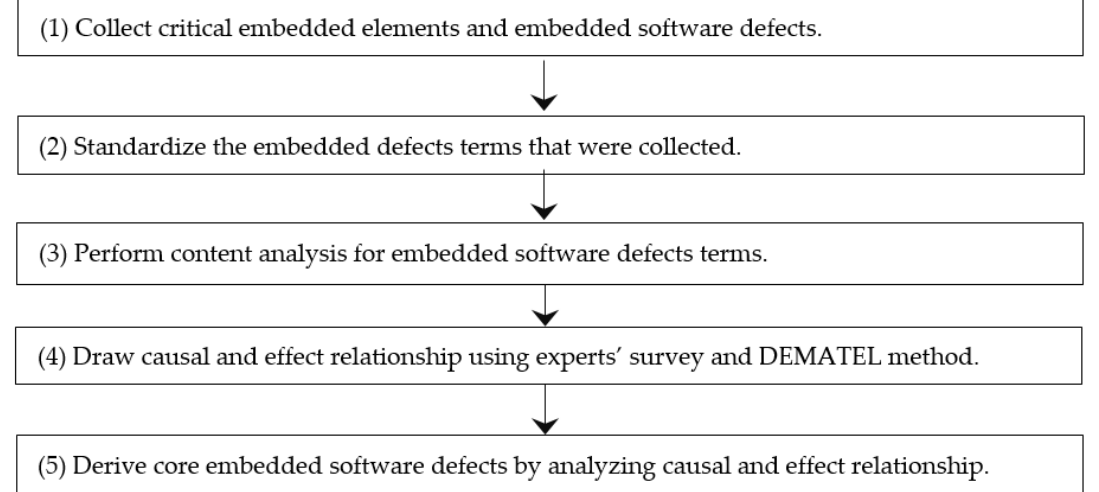
Figure 1. Research procedure for classification of collected defects and derivation of core defects.